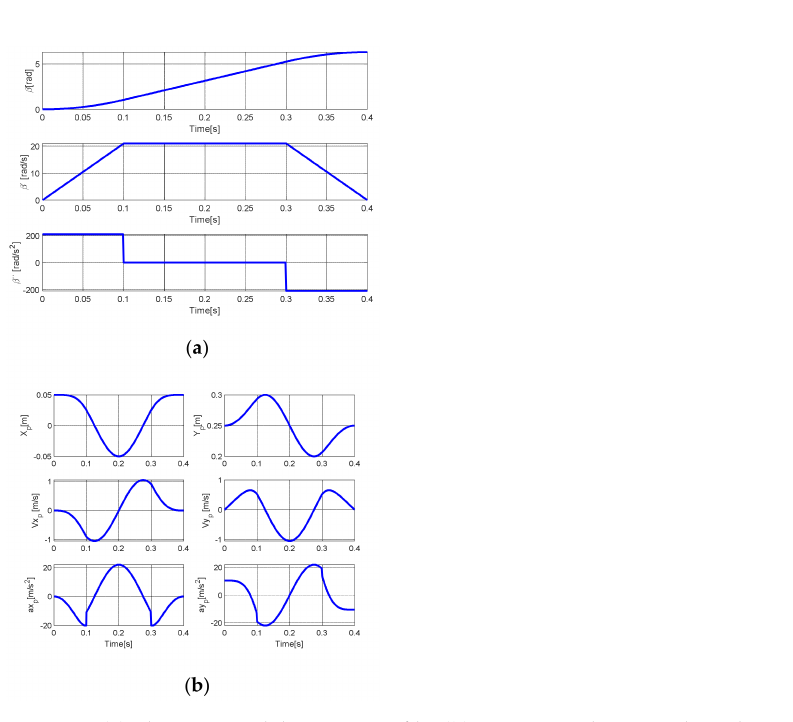
Figure 5. ( a ) The trapezoidal motion profile, ( b ) position, velocity, and acceleration of the endpoint